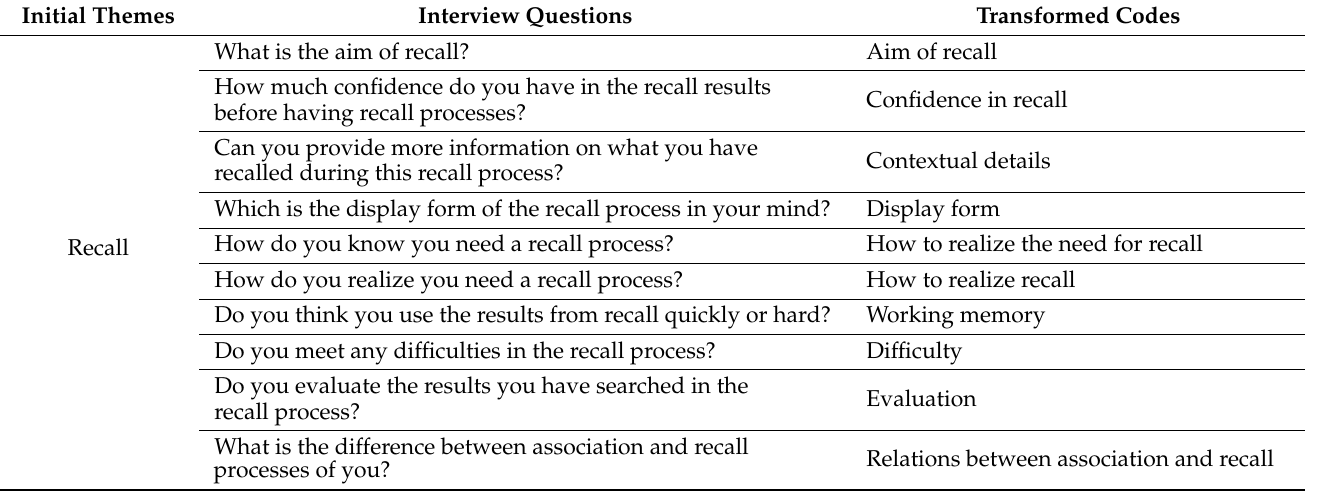
Table 5. Transformation from interview questions to